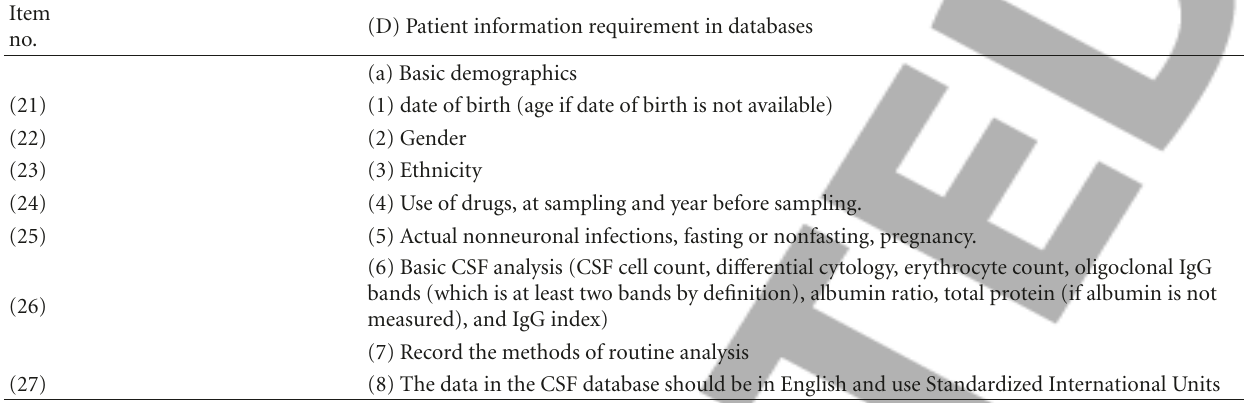
Table 3: Guidelines for patient information requirement in databases of MS